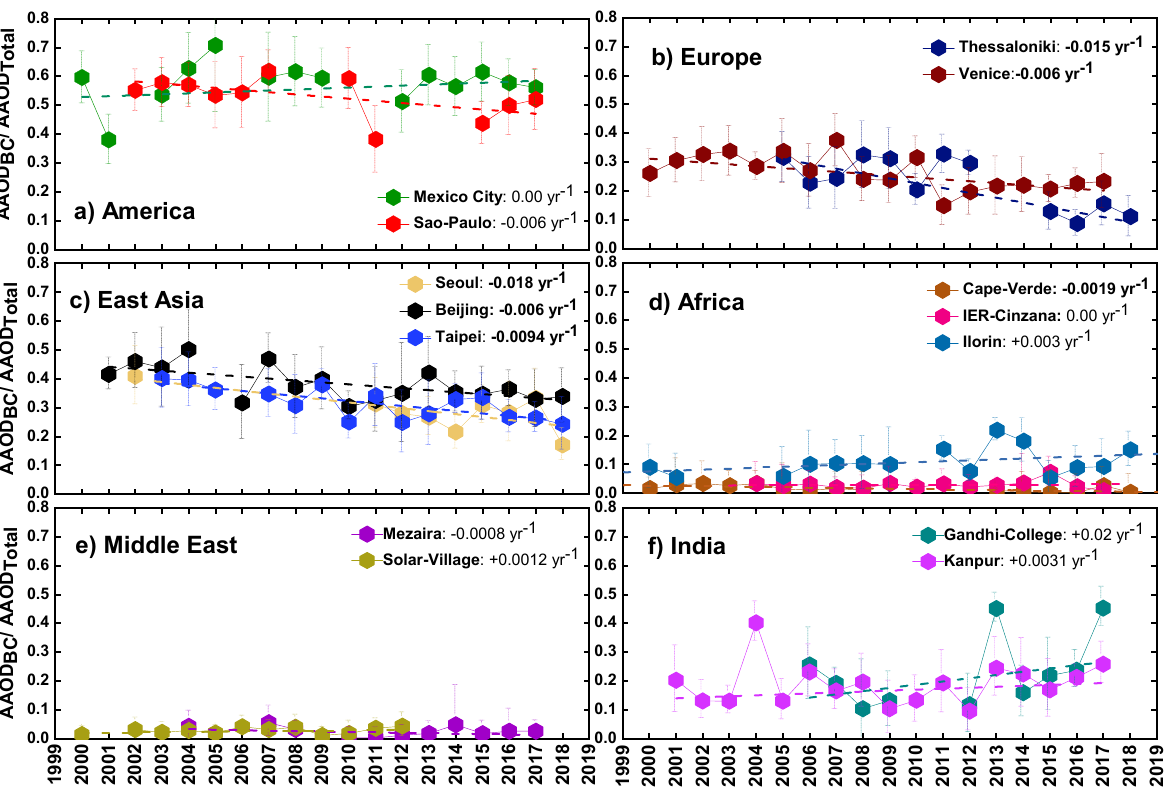
Figure 6. Variations of annual AAOD BC /AAOD Total ratio at 440 nm from 2000 to 2018 at fourteen sites. Error bars represent the standard deviation of the annual averages (units yr − 1 ).